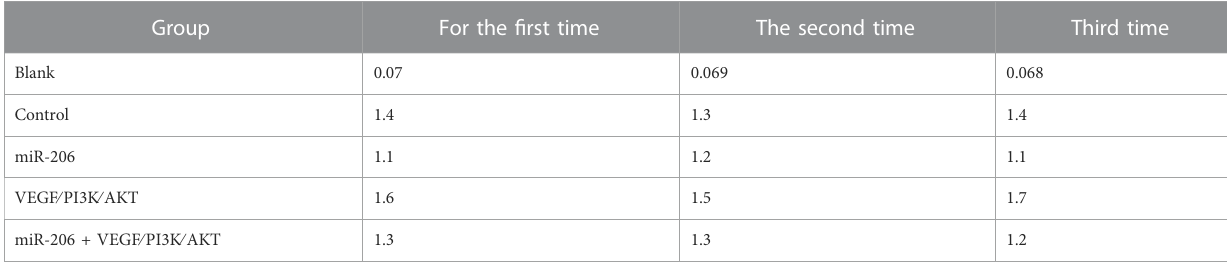
TABLE 3 Relative cell growth rate under different experimental conditions.